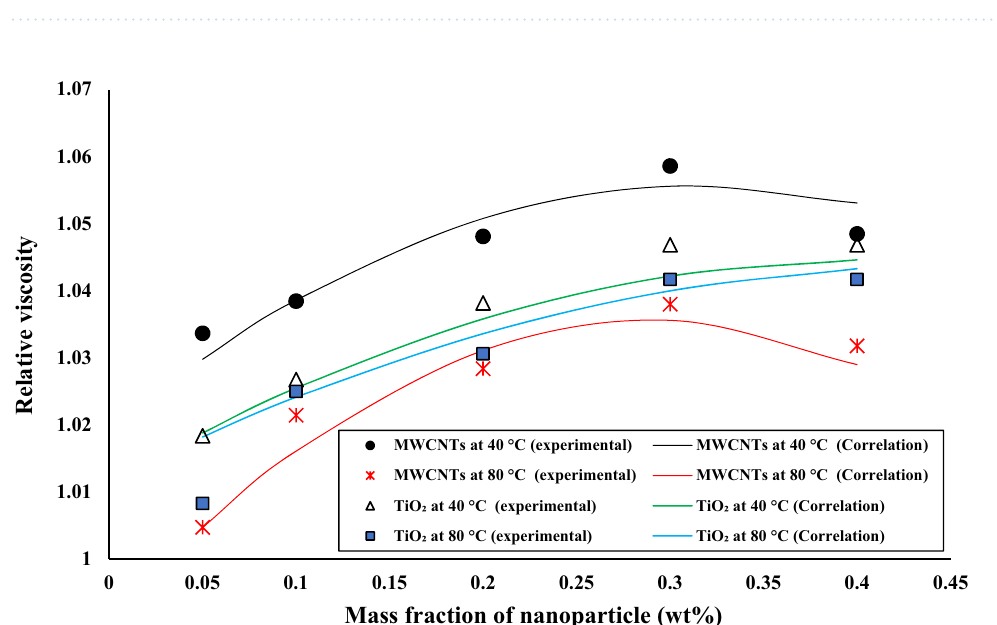
Figure 15. Variation of relative viscosity of TiO 2 /turbine meter and MWCNTs/turbine meter oil nanofluids in different mass